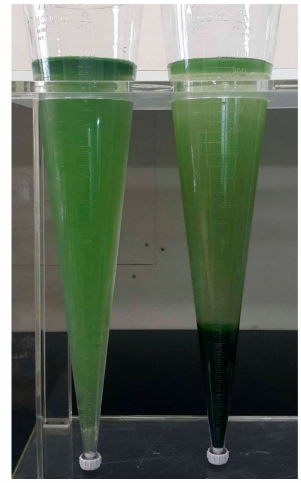
Figure 3. Clearing of algae suspension from the water column after 15 min of exposure to sonication and standing for 1 h. The left Imhoff cone is for the control and the right one for the treated